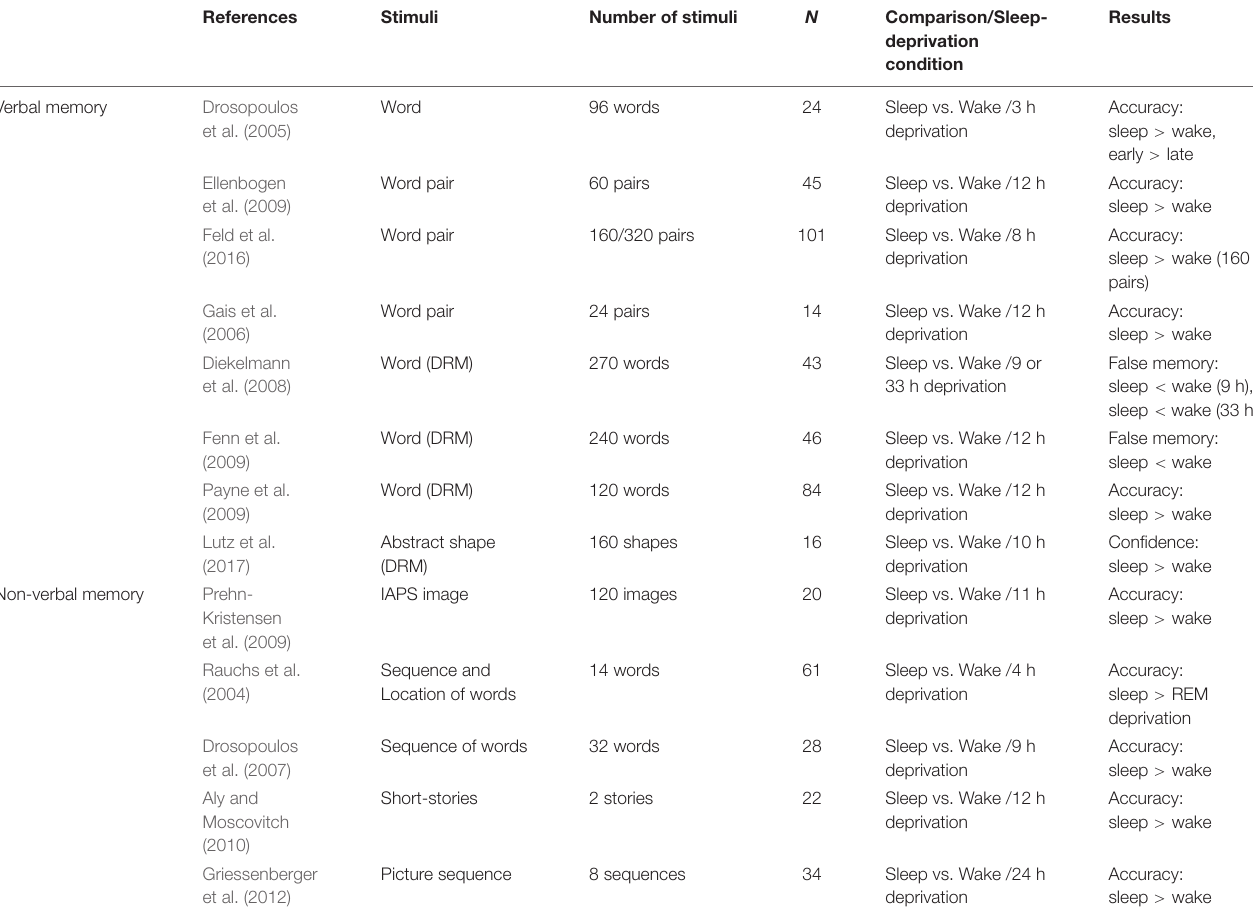
TABLE 1 | Studies of the effects of sleep deprivation on declarative